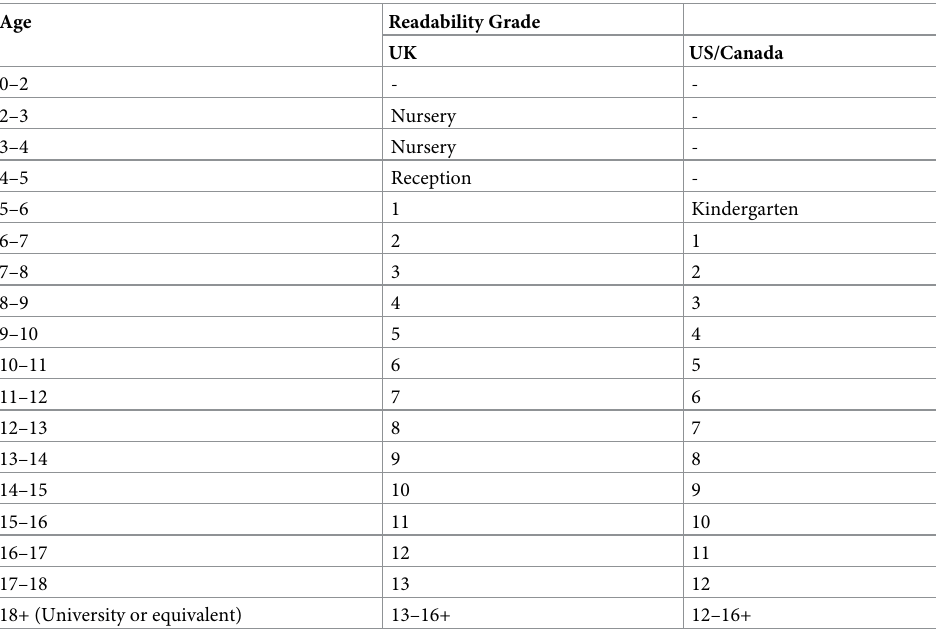
Table 1. Readability grades with equivalent ages in education in the UK and US